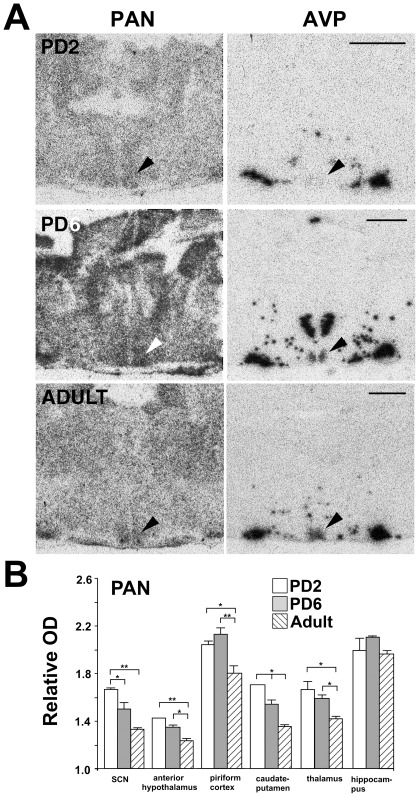
NR1 gene expression in the Siberian hamster forebrain at different developmental ages.(A) Hybridization of the NR1 conserved region probe, PAN (left), and arginine vasopressin (AVP) (right). Autoradiographs of coronal sections taken through the Siberian hamster forebrain at the level of the SCN (arrow) at the ages PD2 (top), PD6 and adult (bottom). AVP identifies the dorso-medial zone of the SCN. Note low level of AVP expression at PD2, in line with published reports in the rat during early development [79]. The PD2 section presented for the PAN probe is of a lower exposure time, allowing for better resolution of SCN region. Quantification was conducted on sections receiving equal exposure time. Scale bars = 1000 µm. (B) Quantification of PAN probe hybridization in various forebrain regions in hamsters of ages PD2, PD6 and adult. Brain regions are suprachiasmatic nucleus (SCN), anterior hypothalamus, piriform cortex, caudate-putamen, thalamus, and hippocampus. Probe hybridization signal was measured as relative optical density (OD), representing relative levels of gene expression (OD of specific brain region divided by OD of corpus callosum in same section). Values represent the mean ± standard error of the mean (SEM) relative OD values from 3 to 5 animals. *P<0.05 and **P<0.01 when regional relative OD is age compared (Dunnett's post-hoc t-test).